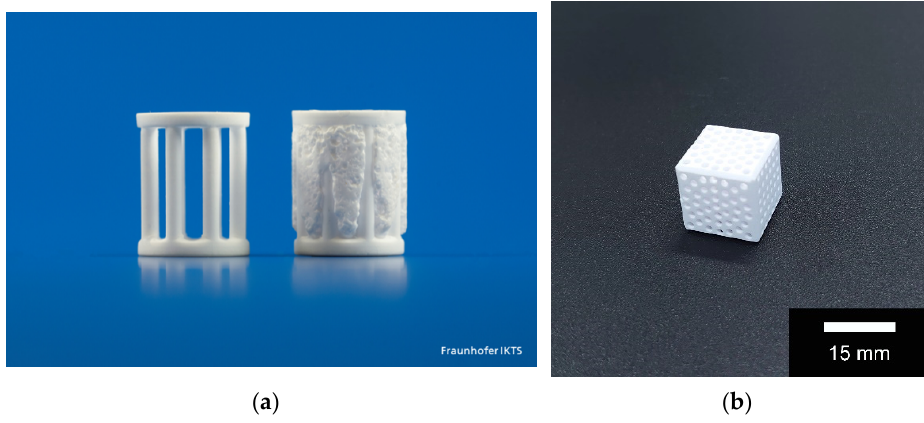
Figure 2. Overview samples vs. Curasan control: ( a ) VPP-manufactured column support structure (left) and hybrid with Freeze Foam enclosing the VPP support (same figure, right); ( b ) Curasan control.